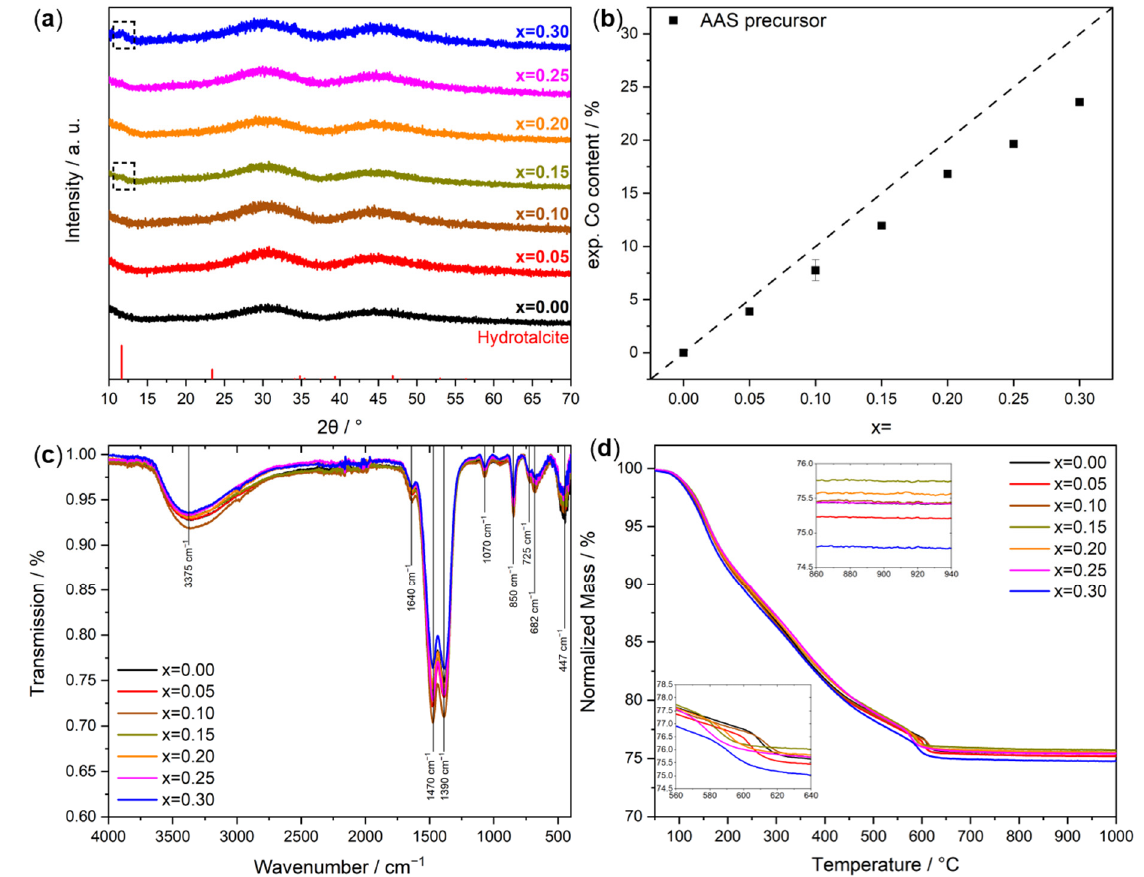
Figure 2. ( a ) XRD powder patterns of the as-prepared sample series. ( b ) Co contents in the samples before calcination. ( c ) ATR-FTIR spectra of the samples before calcination. ( d ) Thermogravimetry mass losses.